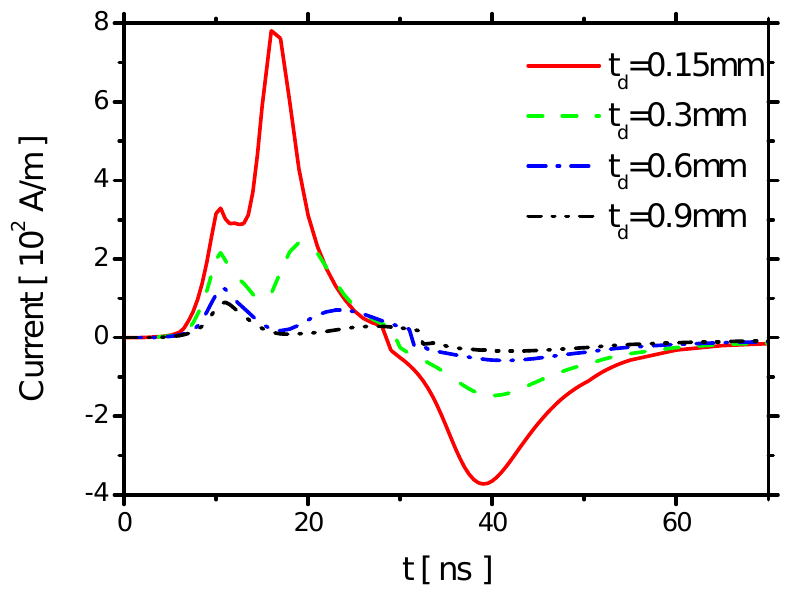
Figure 23. Effects of t d on the